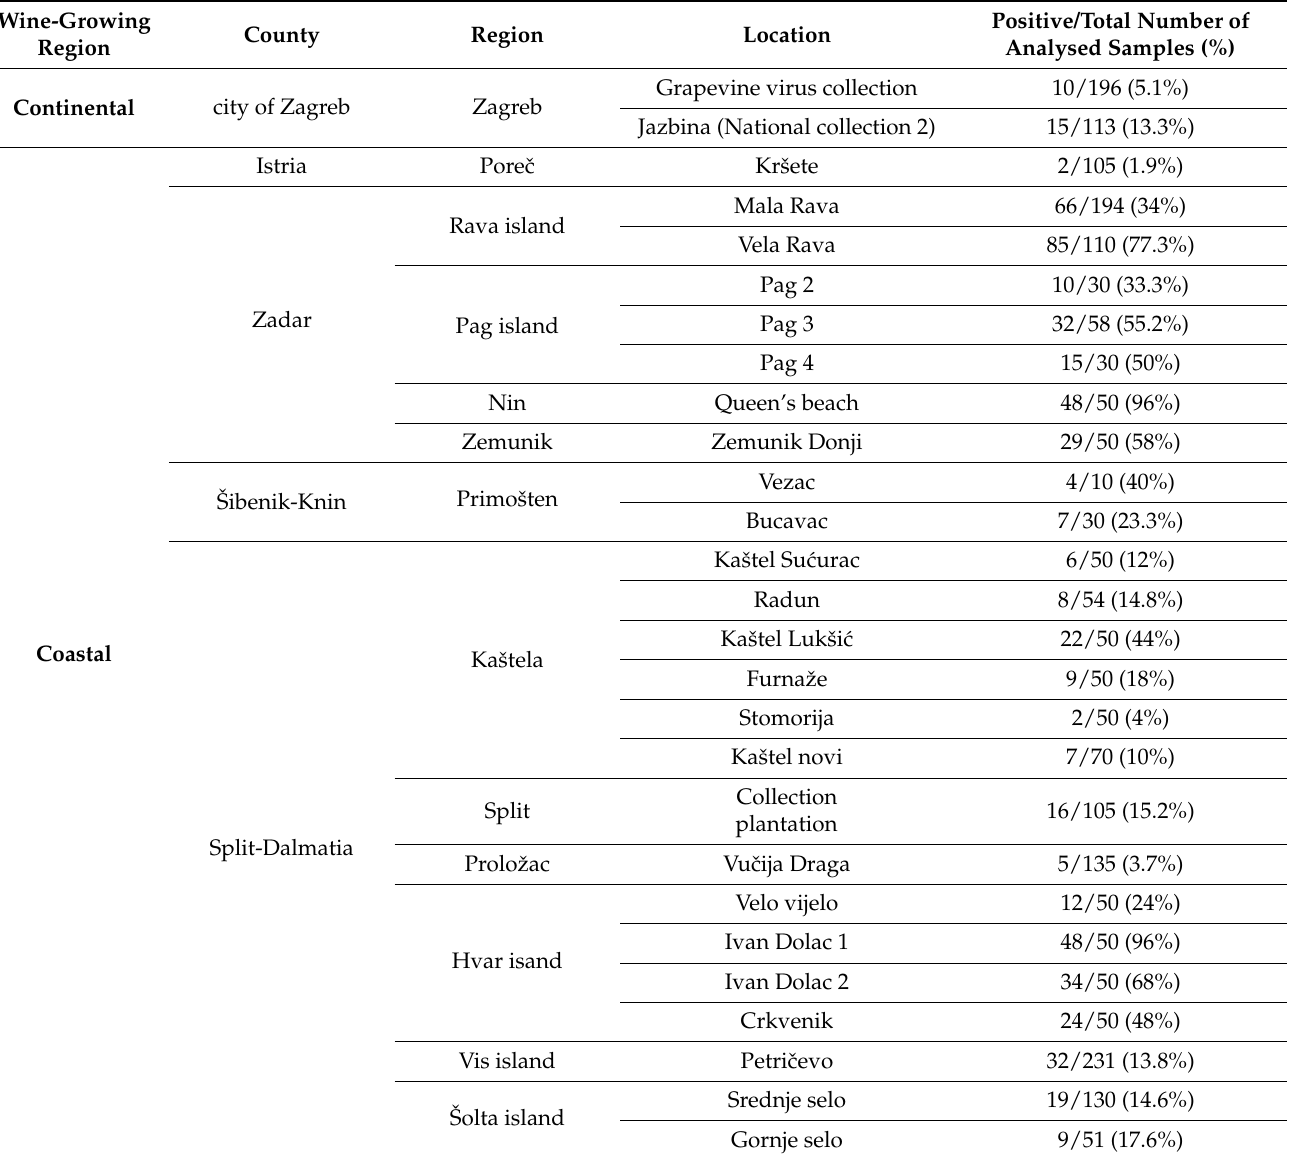
Table 2. Number of GBV-1-positive grapevines identified by real-time PCR. For each positive location details concerning the location and type of vineyards (commercial or collection) are given. Only locations where presence of GBV-1 was confirmed are